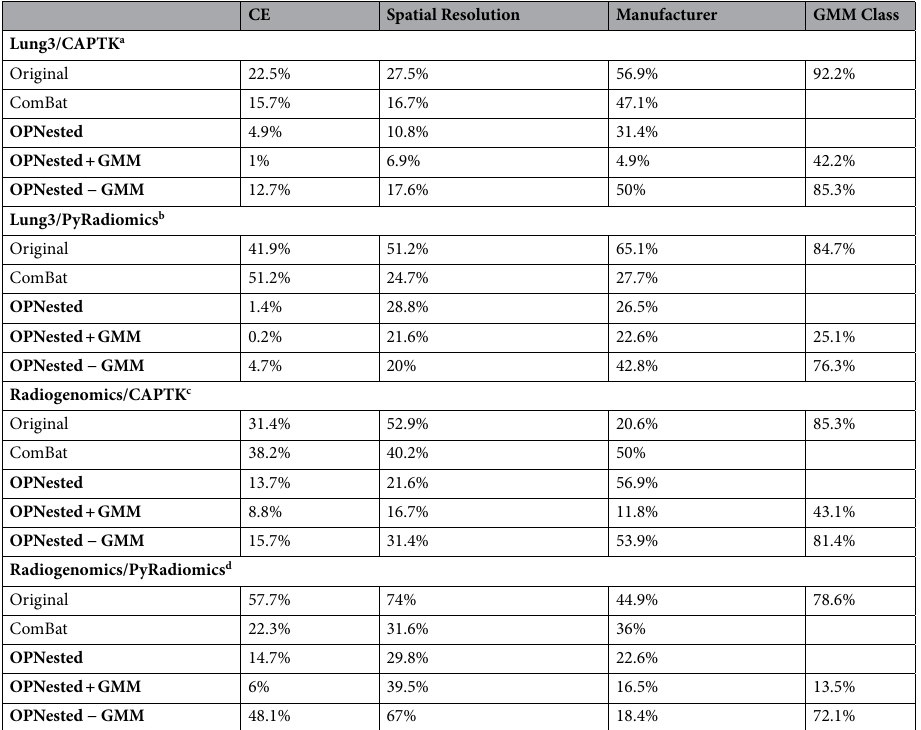
across all datasets (percentage difference for OPNested ComBat subtracted from standard ComBat: −10.8%, −49.8%, −24.5%. −7.6% for Lung3/CAPTK, Lung3/PyRadiomics, Radiogenomics/CAPTK, and Radiogenom- ics/PyRadiomics, respectively, when split by contrast enhancement). This was an improvement over the previ- ous version where OPNested ComBat was only able to demonstrate comparable performance when compared to standard ComBat 23 . The application of OPNested + GMM ComBat resulted in the greatest reduction in the percentage of features with significant differences associated with known batch effects across all datasets (per- centage difference for OPNested + GMM ComBat subtracted from Original: −21.5%, −41.7%, −2.6%, −51.7% for Lung3/CAPTK, Lung3/PyRadiomics, Radiogenomics/CAPTK, and Radiogenomics/PyRadiomics, respectively, when split by contrast enhancement). OPNested + GMM ComBat also successfully reduced the percentage of features with significant differences in distribution due to the inferred GMM grouping (percentage difference for OPNested + GMM subtracted from Original: −50%, −59.6%, −42.2%, 65.1% for Lung3/CAPTK, Lung3/ PyRadiomics, Radiogenomics/CAPTK, and Radiogenomics/PyRadiomics, respectively, when split by contrast enhancement), a reduction that was much smaller in magnitude in the features harmonized with OPNested- GMM ComBat (percentage difference for OPNested–GMM ComBat subtracted from Original: −6.9%, −8.4%, −3.9%, −6.5% for Lung3/CAPTK, Lung3/PyRadiomics, Radiogenomics/CAPTK, and Radiogenomics/PyRadi- omics, respectively, when split by contrast enhancement). Harmonization with OPNested − GMM ComBat also resulted in a smaller reduction in the percentage of features with significant differences due to the known indi- vidual batch effects when compared to OPNested + GMM ComBat and OPNested ComBat in all datasets (per- centage difference for OPNested − GMM ComBat subtracted from Original: −9.8%, −37.2%, −15.7%, −9.6% for